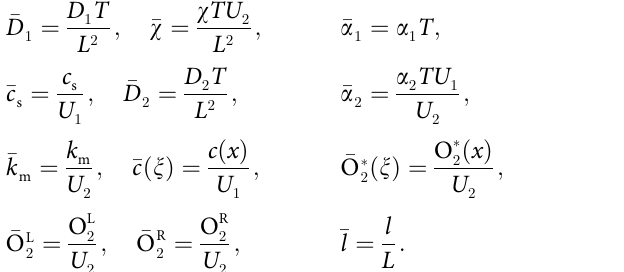
x . The duration of the